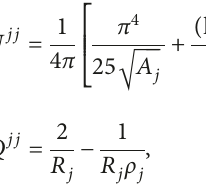
sound pressure in water (10 − 6 pa).